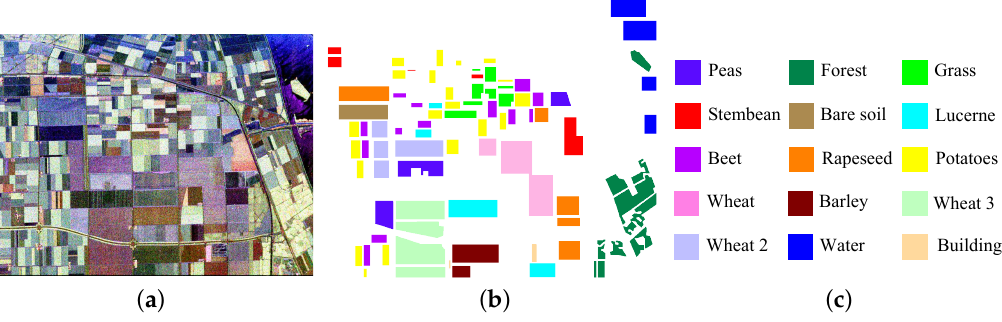
Figure 4. Pauli RGB pseudo-colored image and terrain information from PolSAR database Flevoland from NASA/JPL AIRSAR: ( a ) Pauli RGB pseudo-colored image, ( b ) ground-truth image, and ( c ) terrains in this